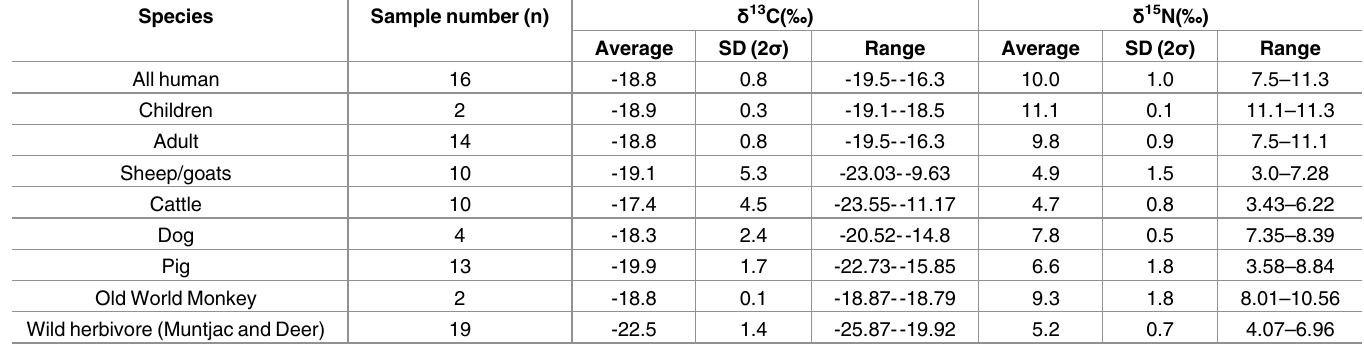
Table 3. Summaryof human and animal isotopic data. Adults includesamples from individualsover 25 years old. Childrenincludetwo bone samples from individuals under 25 years old. SD: Standard deviation.